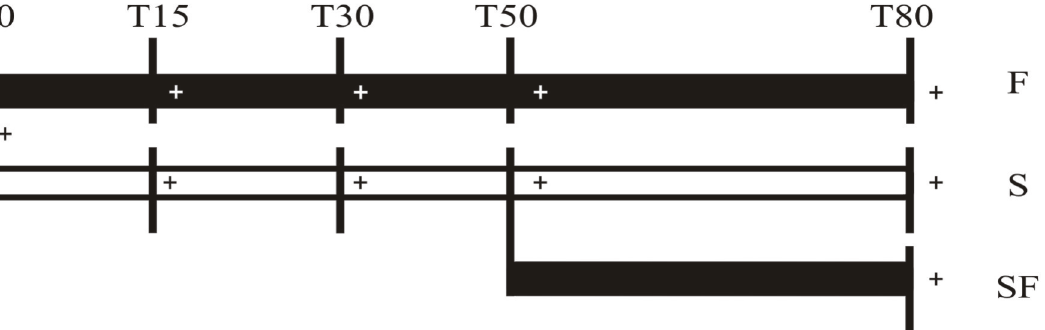
Fig 1. Experimental design scheme used to study the effect of long fasting in Cherax quadricarinatus juveniles. Treatments: F: Fed Group; S: Starved Group and SF: Starved-fed Group. T0: end of the acclimation week; T15: 15 days of experiment; T30: 30 days of experiment; T50: 50 days of experiment and T80: 80 days of experiment. The symbol “ + ” indicate that 10 animals were